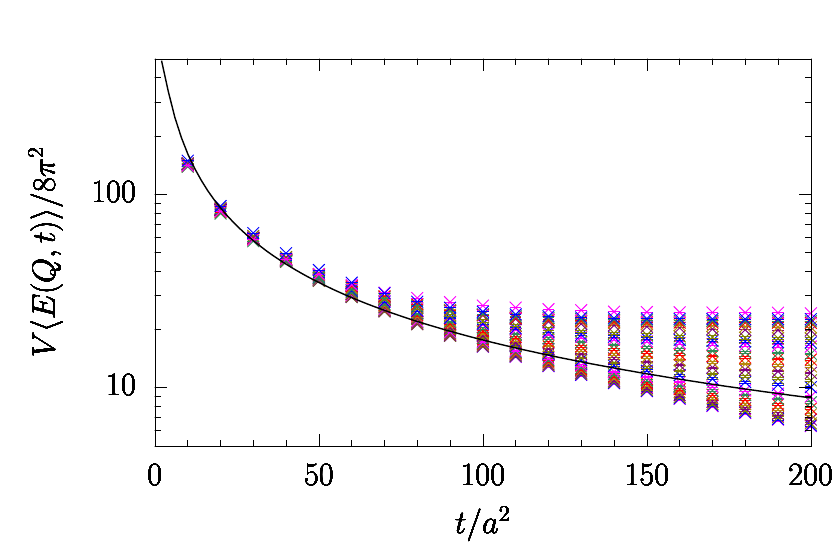
Figure 4: The action V 〈 E ( Q , t ) 〉 / 8 π 2 according to | Q | as a function of flow time on the 32 4 lattice for charges ranging from Q = 0 (bottom) to | Q | = 22 (top). The solid line represents the ensemble average.